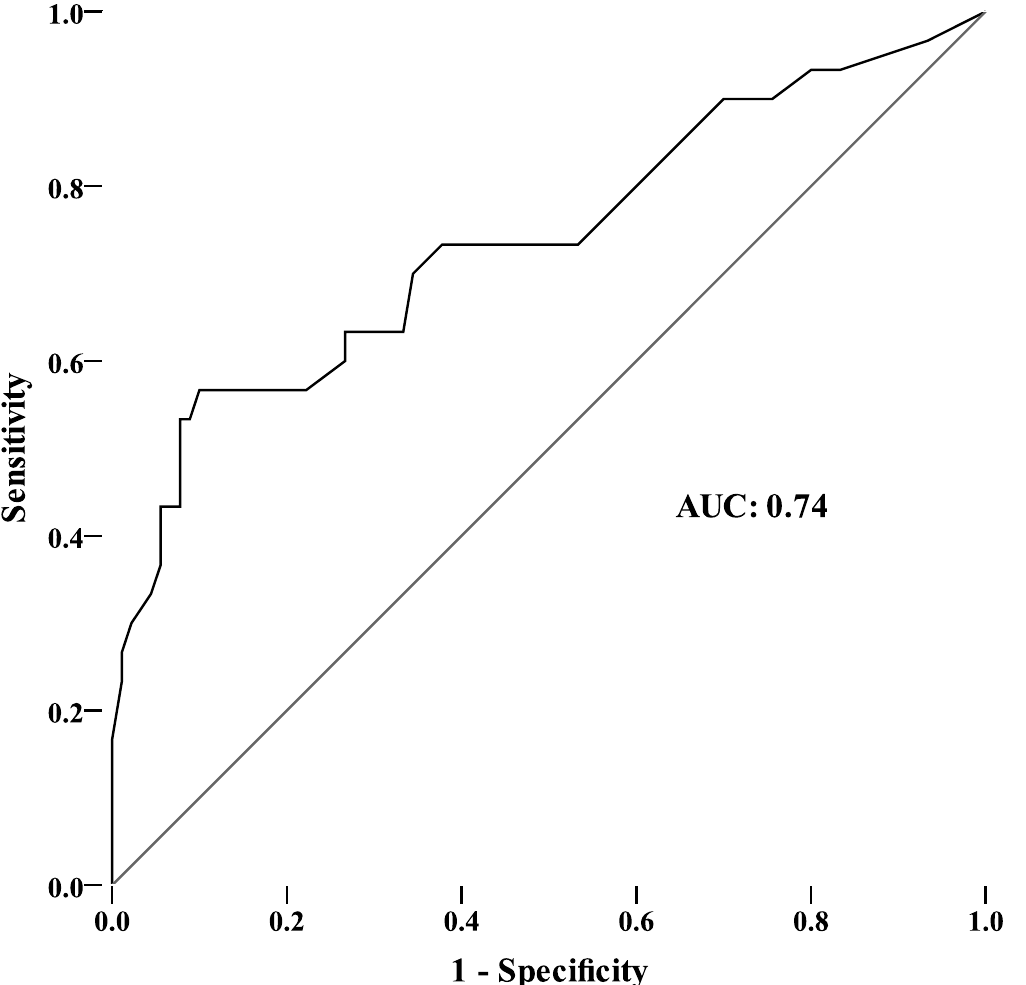
Figure 1. Receiver operating characteristic curve analysis of the Berg Balance Scale (BBS) score at admission for predicting community ambulation ability at discharge (6MWT distance ≥ 205 m).